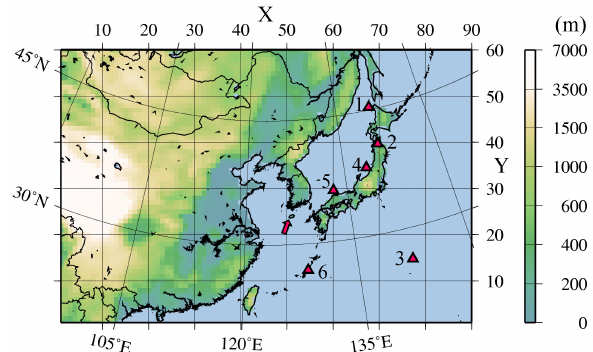
Figure 1. Model domain showing terrestrial elevation (m) and the six Japanese EANET sites 2 Fig. 1. Model domain showing terrestrial elevation (m) and the (1. Rishiri, 2. Tappi, 3. Ogasawara, 4. Sado, 5. Oki, 6. Hedo) and the CHAAMS sites (located 3 six Japanese EANET sites (1. Rishiri, 2. Tappi, 3. Ogasawara, 4. in the same premises as the EANET Hedo stations). The descriptions of the locations are 4 Sado, 5. Oki, 6. Hedo) and the CHAAMS sites (located on the same given in Table 4. An arrow indicates the Gosan site on Jeju Island, Korea. 5 premises as the EANET Hedo stations). The descriptions of the lo- cations are given in Table 4. An arrow indicates the Gosan site on Jeju Island,